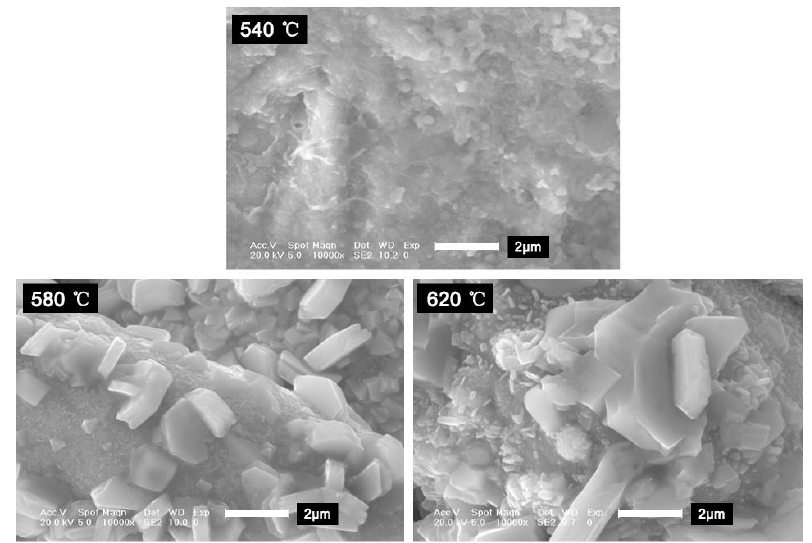
Figure 9. SEM images of parts sintered at different temperatures (magnified 10,000 times).